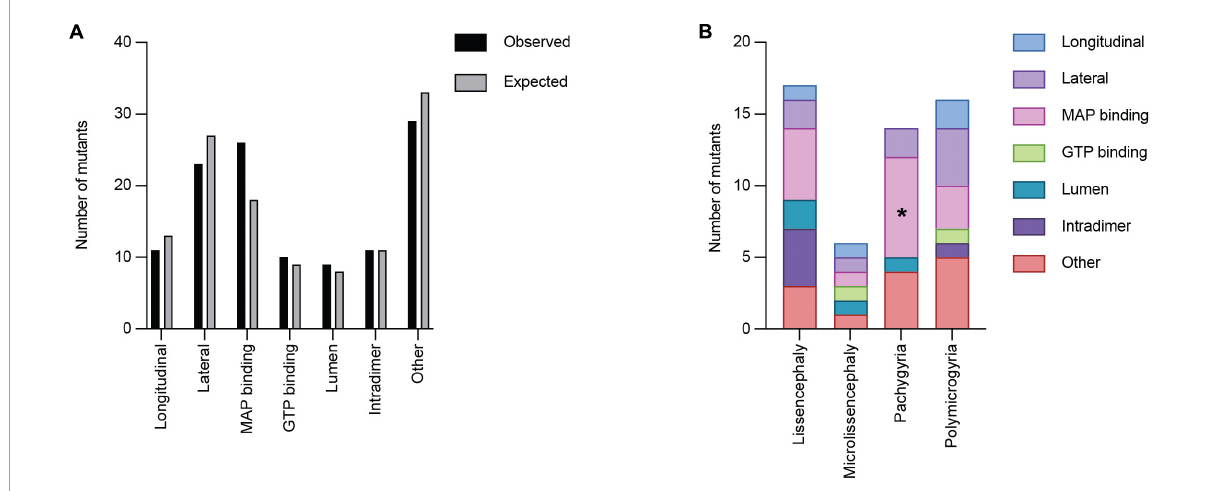
FIGURE6 Quantifying TUBA1A mutations by functional region. (A) TUBA1A mutations were sorted by the functional domains (longitudinal, lateral, MAP binding, GTP binding, lumen, intradimer, or other) in which they reside. Observed and expected number of mutations were compared using a Chi-squared test [12.59 critical value when α = 0.05; X 2 (df = 6, N = 119) = 5.177; p = 0.5]2). The expected number of mutations in each functional domain was calculated by determining the percentage of amino acids that reside in each domain, then multiplying that by 119 (the number of TUBA1A missense mutations known to date). This value represents the number of mutations that would be expected to appear in each domain if all 119 mutations were randomly distributed. (B) TUBA1A mutations were sorted by the primary cortical malformation resulting from each mutation (lissencephaly, microlissencephaly, pachygyria, or polymicrogyria). For each cortical malformation, the number of mutations in each functional domain was reported. A Fisher’s exact test was run for each cortical malformation category to determine if mutations were enriched in one functional domain over the others. Asterisk (*) on bar indicates p -value < 0.05 (pachygyria MAP binding p <